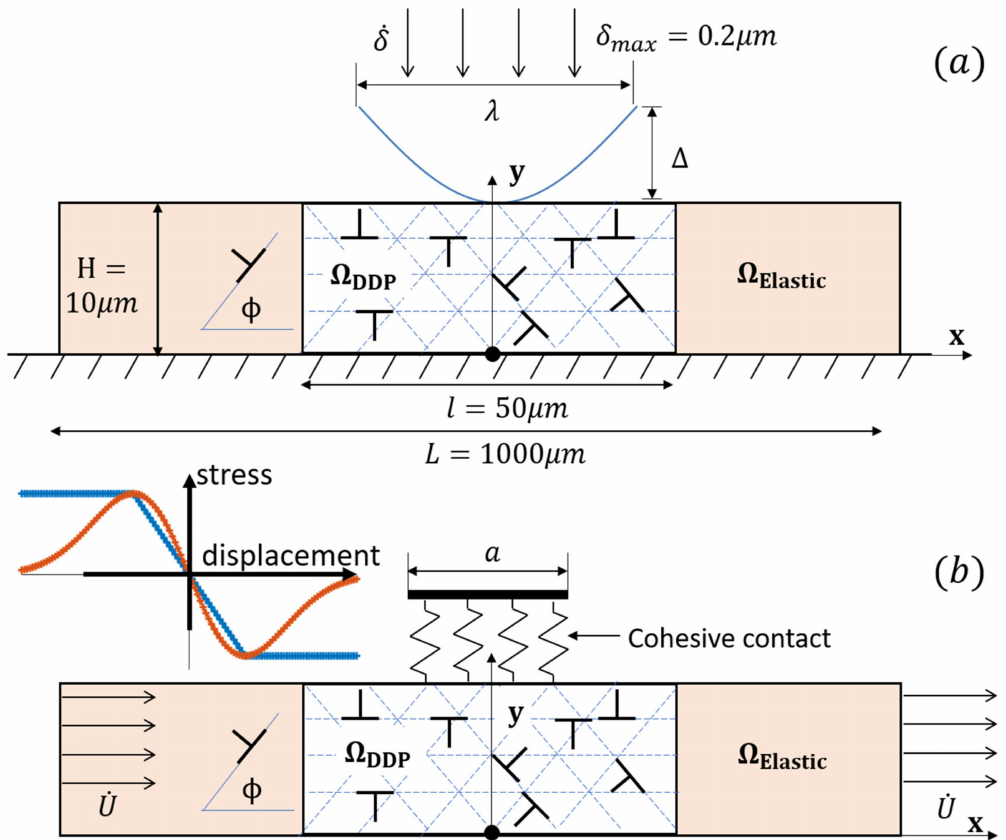
Figure 1. Schematic diagrams of the ( a ) sinusoidal indentation and ( b ) nano-sliding and fretting boundary value problems analysed using a discrete dislocation plasticity framework. The origin of the coordinate system employed is marked as a filled-in circle ( • ) in ( a ) and ( b ). The softening and non-softening cohesive relation between shear traction and jump displacement on contact partition is illustrated in ( b ). The non-softening relation is utilized for the fretting